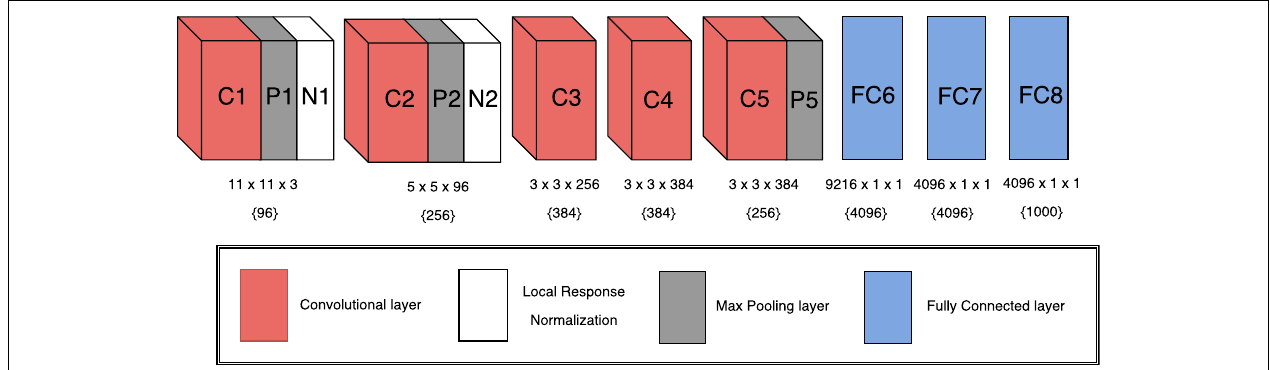
FIGURE 1 | An illustration of the weights in the AlexNet model . Note that after every layer, there is an implicit ReLU non-linearity. The number inside curly braces represents the number of filters with dimensions mentioned above it.